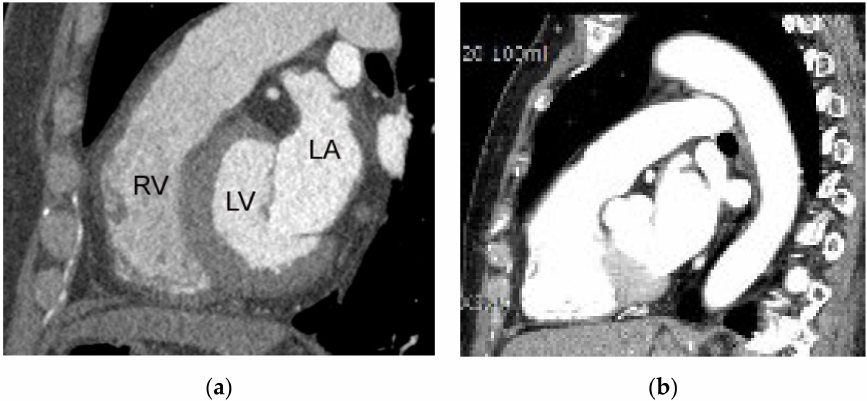
Figure 1. Typical z-axis coverage of dedicated coronary CTA versus triple-rule-out. ( a ) Z-axis coverage of dedicated coronary CTA includes the lower two-thirds of the entire chest. ( b ) The entire chest constitutes the z-axis coverage of the triple-rule-out CT. RV, LA, and LV indicate right ventricle, left atrium, and left ventricle,